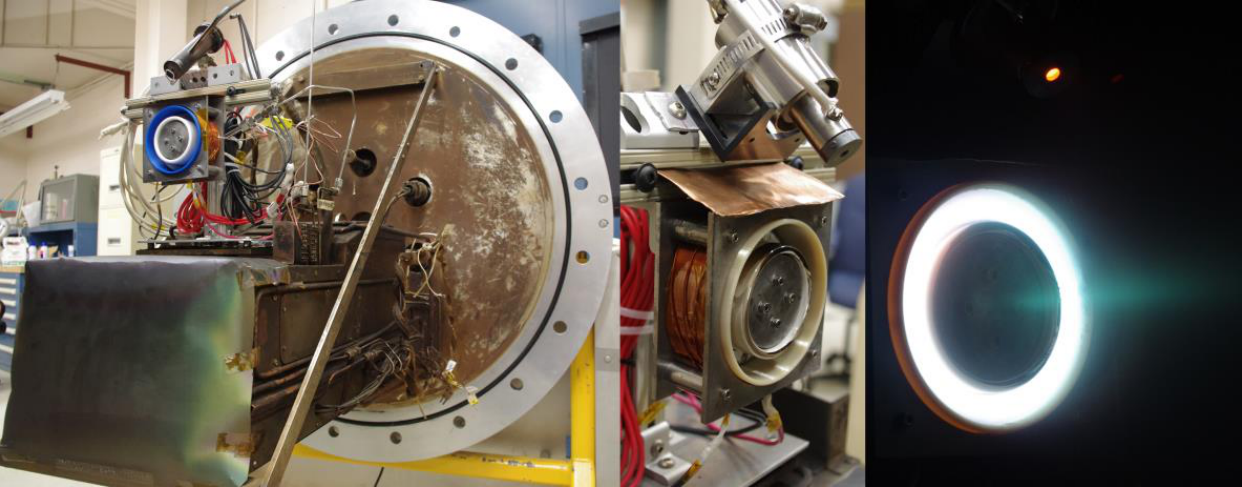
Figure 1. Testing of the UAH-78AM at GRC.